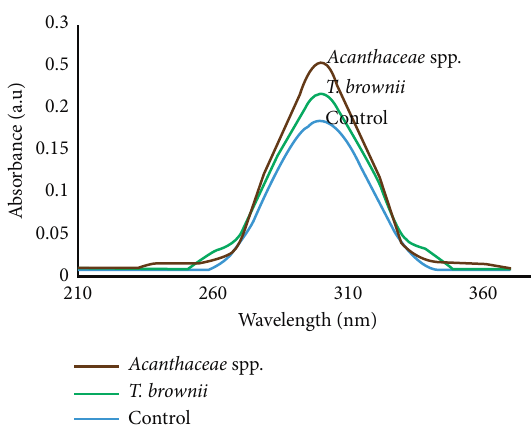
Figure 3: Nitrate levels in bioslurry after retention day 28. Table 7: Variation in total sulfur and free sulfate levels over the retention